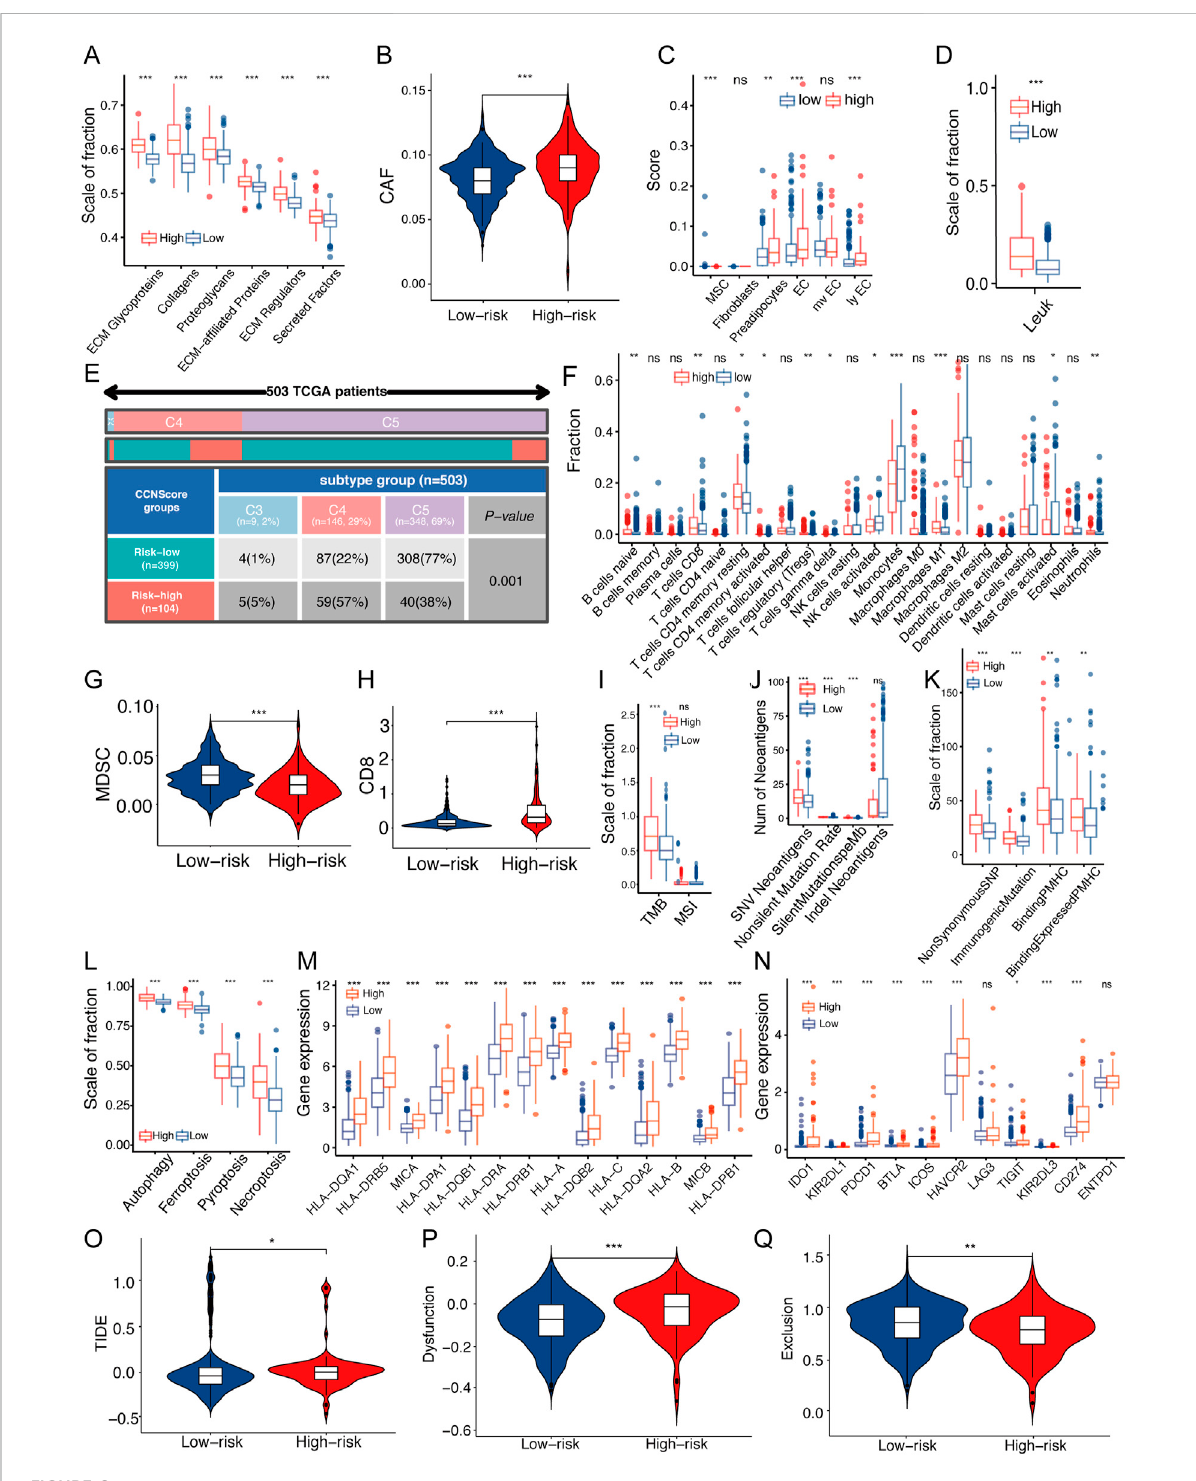
FIGURE 6 Relationship between CCNScore and TME of LGG. (A) Differences in extracellular matrix components of TME in Low-CCNScore and High- CCNScore groups. (B,C) Differences in CAF (B) and normal stromal cells (C) of TME in Low-CCNScore and High-CCNScore groups. (D) Differences in leukocyte fraction of TME between Low-CCNScore and High-CCNScore groups. (E) The proportion of Low-CCNScore and High-CCNScore among pan-cancer immune subtypes. (F) Differences in tumor-in fi ltrated immunecells of TME between Low-CCNScore and High-CCNScore groups. (G,H) Differences in MDSC (G) and CD8 (H) in TME between Low-CCNScore and High-CCNScore groups. (I – K) Differences in tumor